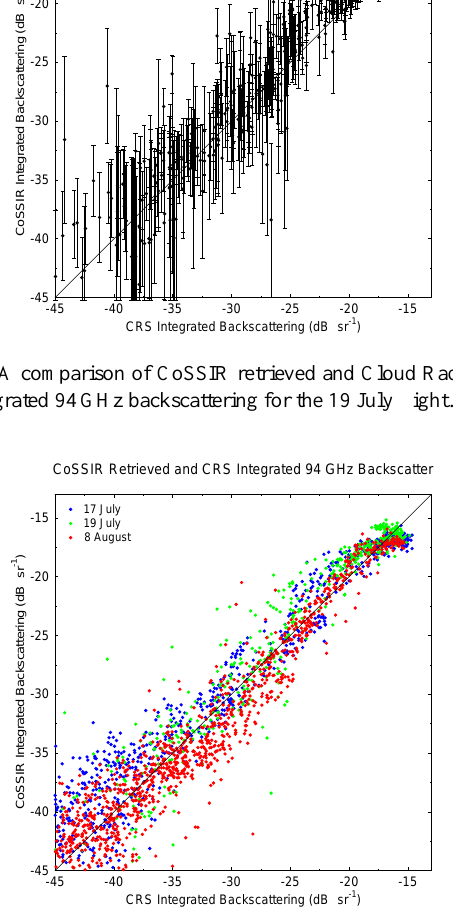
Fig. 16. A comparison of CoSSIR retrieved and Cloud Radar Sys- tem integrated 94GHz backscattering for all three